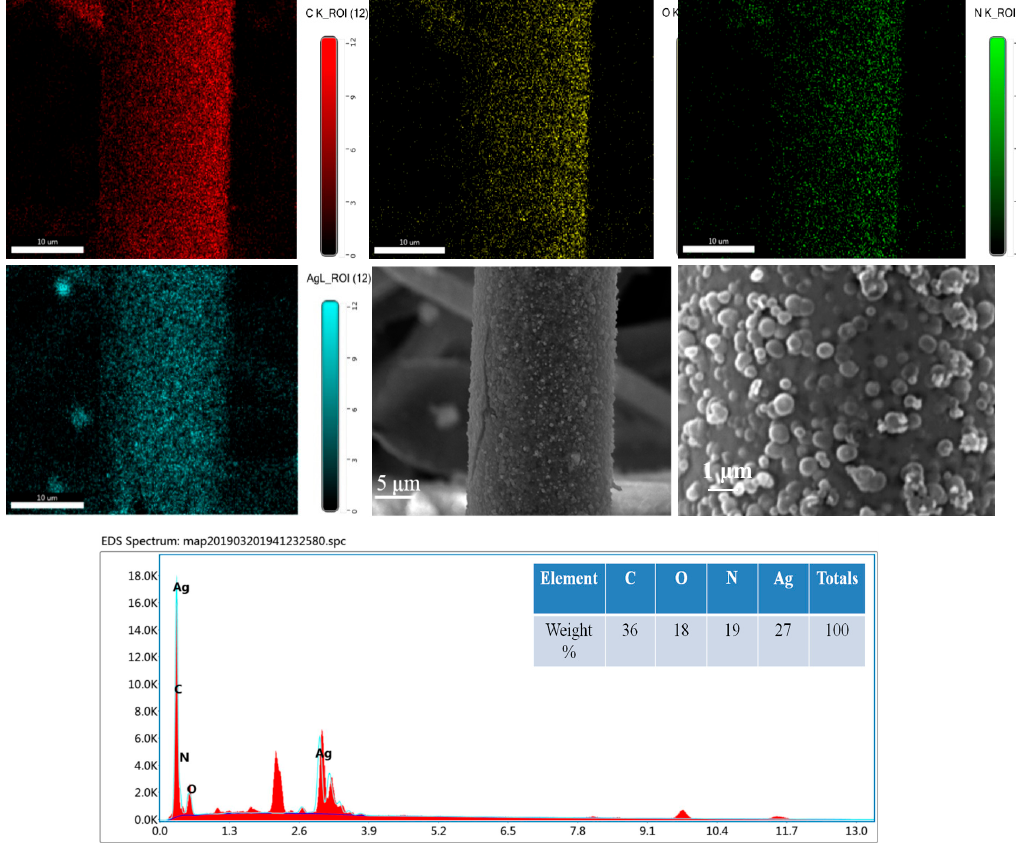
Figure 6. The mapping dots and elements’ weights of the dopamine-treated Ag-coated fabric.